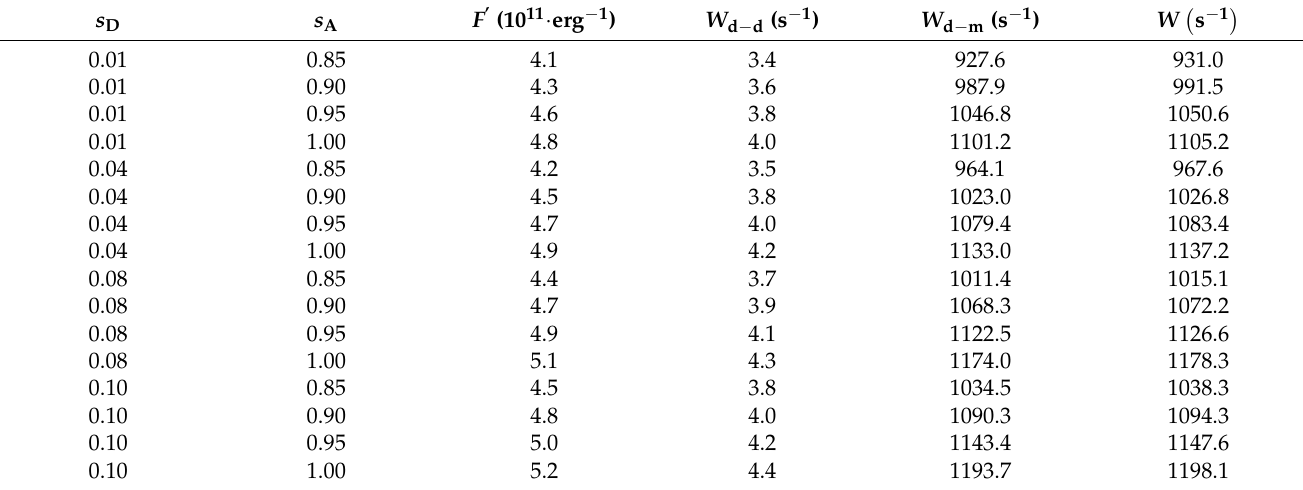
Table 3. Phonon-assisted energy transfer rates ( W ) and their mechanisms’ contributions ( W d − d and W d − m ). The average phonon energy (cid:125) ω = 1120 cm − 1 is considered in a two-phonon process. s D and s A are the Huang–Rhys factors for the donor and acceptor, respectively. F (cid:48) is the phonon- assisted spectral overlap factor (Equation